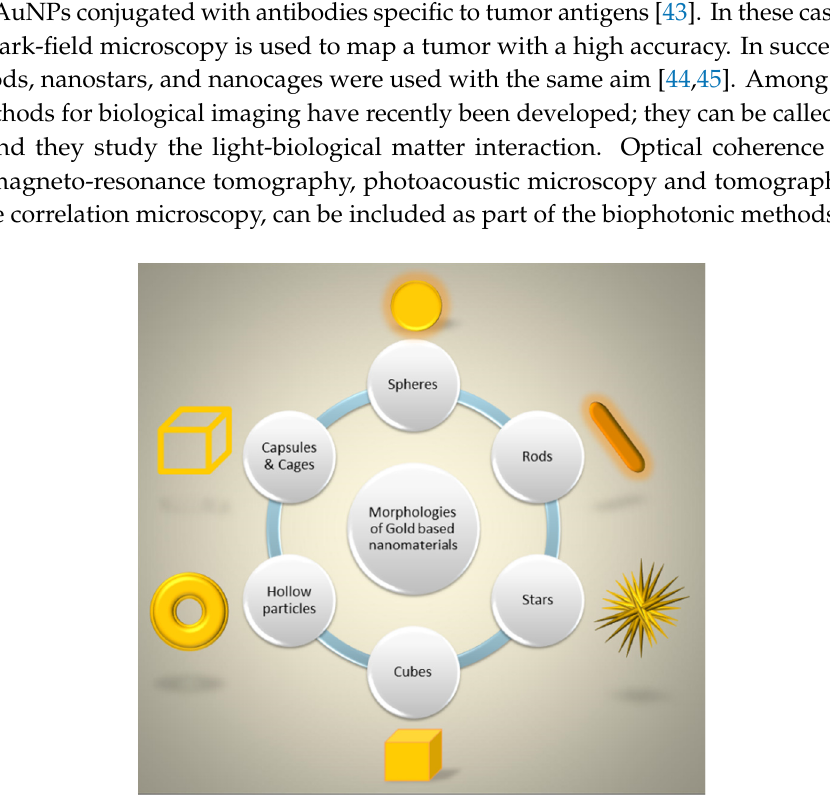
Figure 1. Schematic representation of the main morphologies of gold-based nanomaterials used in biomedical applications.